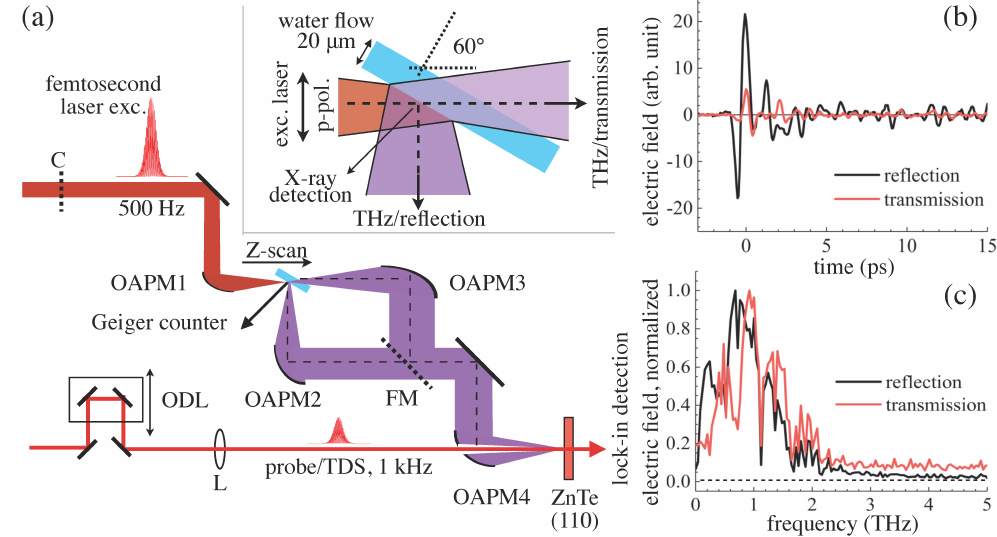
Figure 1. ( a ) The experimental setup for the simultaneous measurements of THz wave (time-domain spectroscopy (TDS)) and X-ray (Geiger counter). The femtosecond laser pulses (<35 fs, 800 nm, 500 Hz, horizontally-polarised to the solution flow surface, i.e., p-pol.) were focused onto the solution flow; ODL, optical delay line for TDS, L-plano-convex lens ( f = 50 cm). The thickness of ZnTe(110) crystal for TDS was 1 mm; C, optical chopper (500 Hz) for TDS measurements. The parent focal lengths for off-axis parabolic mirrors (OAPMs) (off-axis parabolic mirrors) were f = 50.8 mm (OAPM1, 1-inch diameter), 101.6 mm (OAPM2, 2-inch), 152.4 mm (OAPM3, 2-inch) and 101.6 mm (OAPM4, 2-inch with a hole in its centre for the probe), respectively. The distance between the laser focus and Geiger counter was 12 cm. FM, flip-folding mirror for TDS measurements in the transmission direction. The inset shows the close-up of the solution surface, the laser-water interaction region; ( b ) Representative TDS signals from water flow when the laser intensity is 0.4 mJ/pulse in reflection and transmission directions at the Z-position for the highest X-ray intensity and ( c ) their normalized